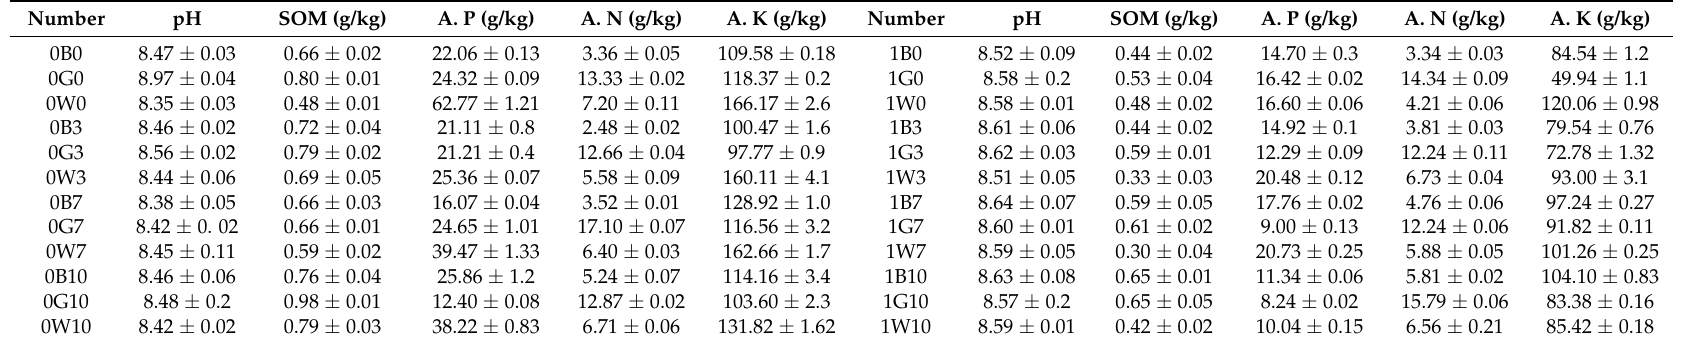
Table 2. Physical and chemical properties of soils for each